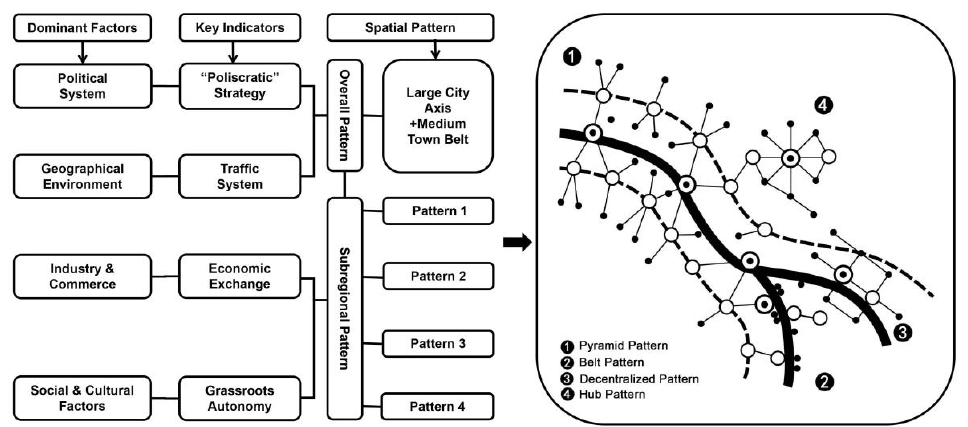
Figure 4. Dominant factors and spatial patterns of the middle and lower Ganges Valley from the 16th to the mid-18th Century. Source: the